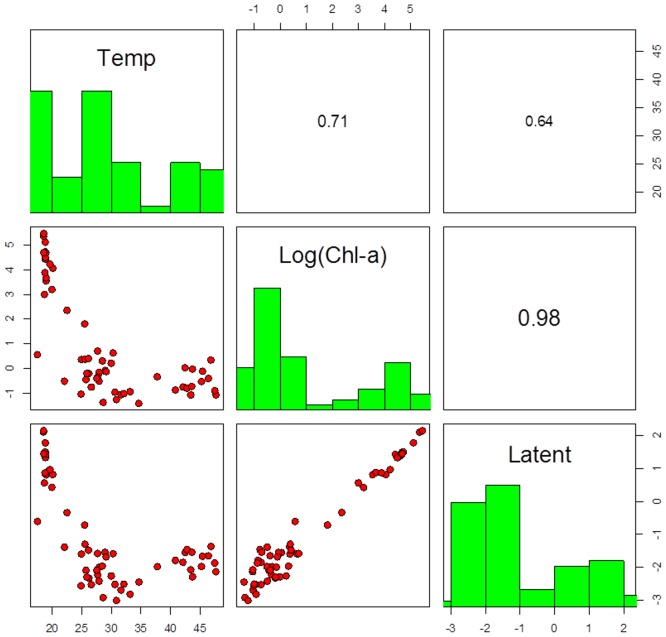
Pairplot of optima obtained from OpenBUGS output for temperature (in °C), chlorophyll-a (in log(µg L
−1)) and latent variable (arbitrary units).